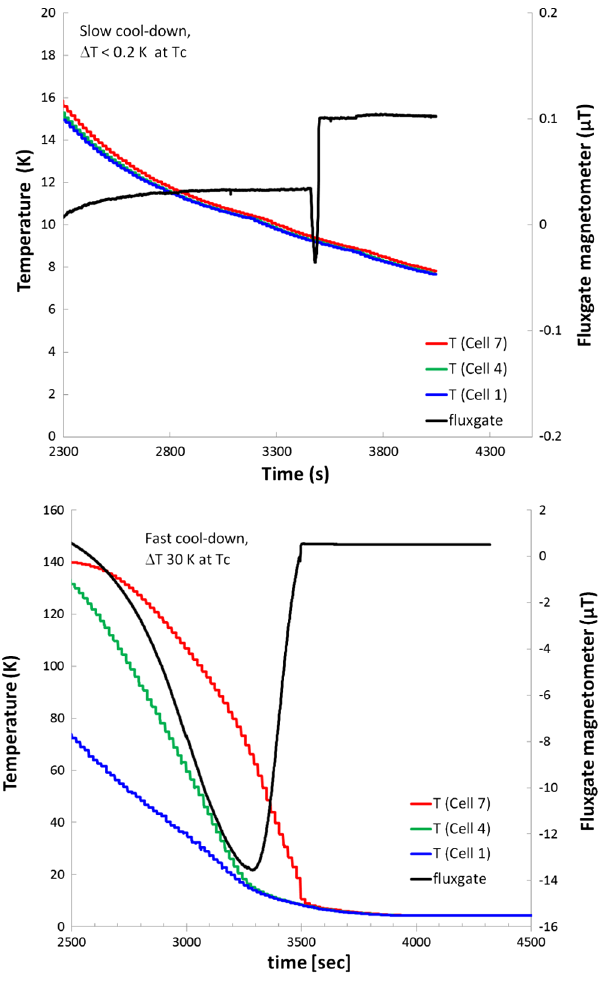
FIG. 5. Slow (upper plot) and fast (lower plot) cooldown cycle: shown are temperatures of the dressed cavity and the magnetic flux measured at the iris location. The residual azimuthal field component inside the cryostat was 0 . 1 μ T at room temperature.